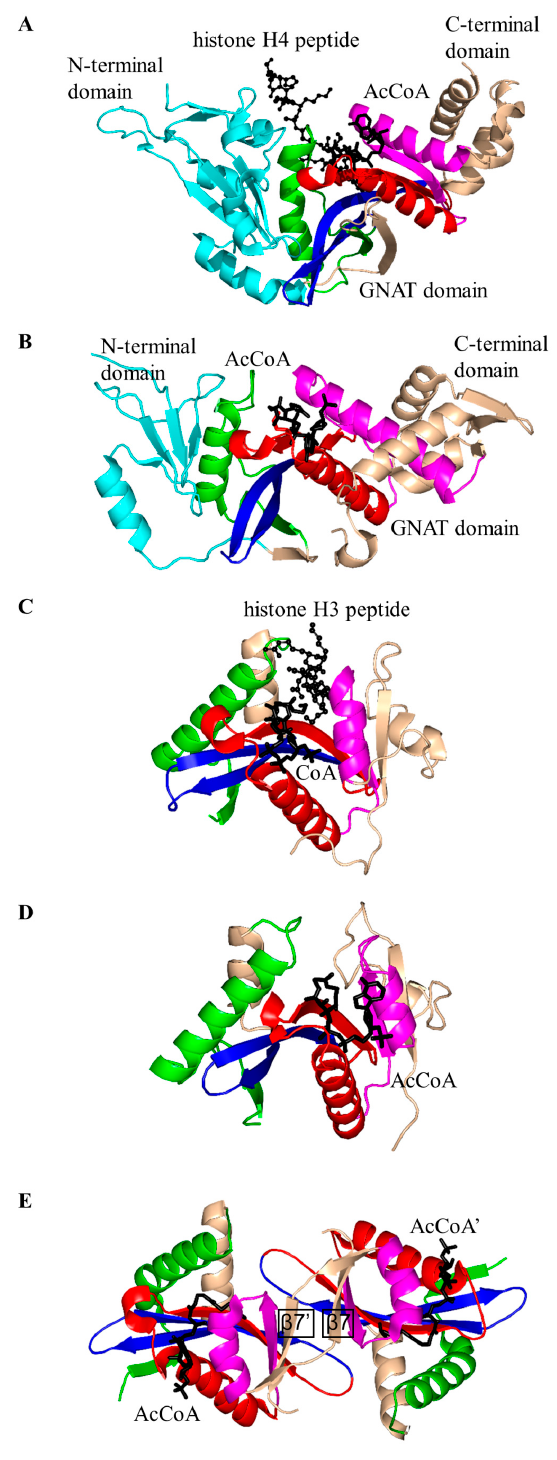
Figure 4. Cartoon representation of the structures of histone N -acetyltransferases. ( A ) Human HAT1 in complex with AcCoA and a histone H4 peptide (PDB ID: 2P0W [45]); ( B ) yeast Esa1 in complex with AcCoA (PDB ID: 1MJB [57]); ( C ) yeast GCN5 acetyltransferase in complex with CoA and a histone H3 peptide (PDB ID:1QSN [70]); ( D ) the histone acetyltransferase domain of hPCAF in complex with CoA (PDB ID: 1CM0 [73]); and ( E ) yeast Hpa2 histone acetyltransferase in complex with AcCoA (one dimer of the tetramer) (PDB ID: 1QSM [76]). In HAT1 and Esa1, the N-terminal domain is colored cyan, C-terminal domain is colored wheat, and conserved and non-conserved motifs of the central GNAT domain are colored as in Figure 1.